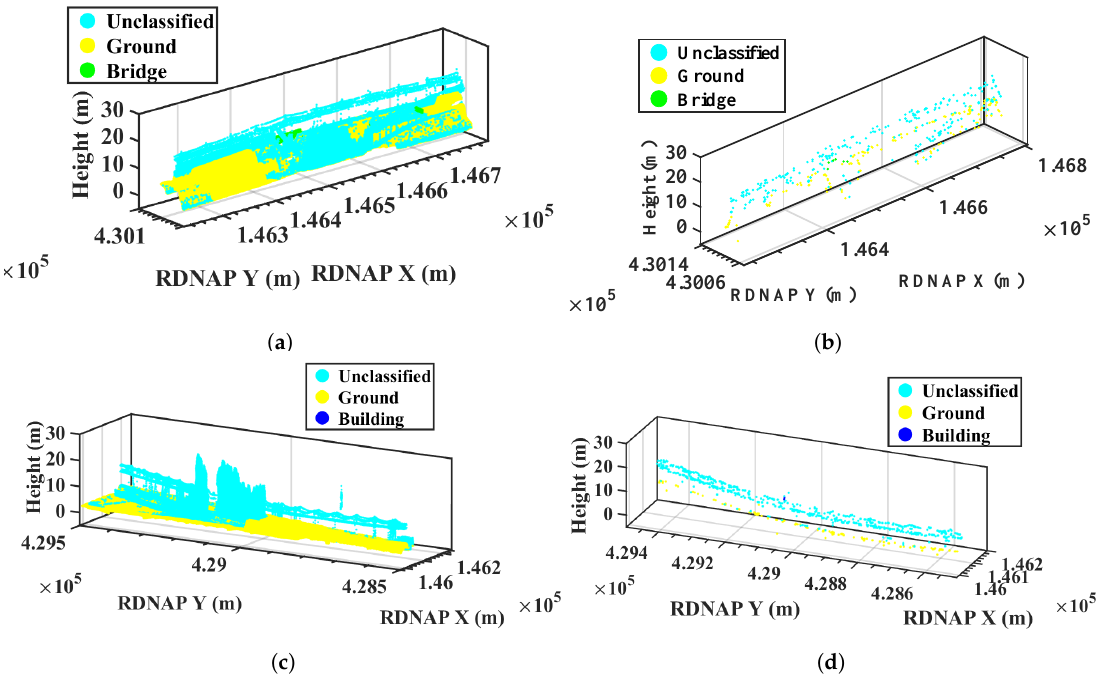
Figure 15. Classification maps of two selected areas: ( a , c ) classification maps of LiDAR; and ( b , d ) classification maps of radar scatterers, showing the importance of including the unclassified